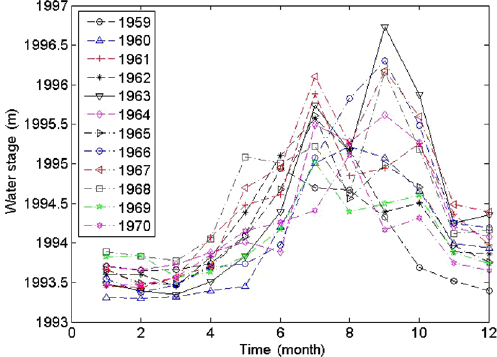
Figure 7. Monthly stage change of the Maqu hydrological sta- tion (1959–1970).